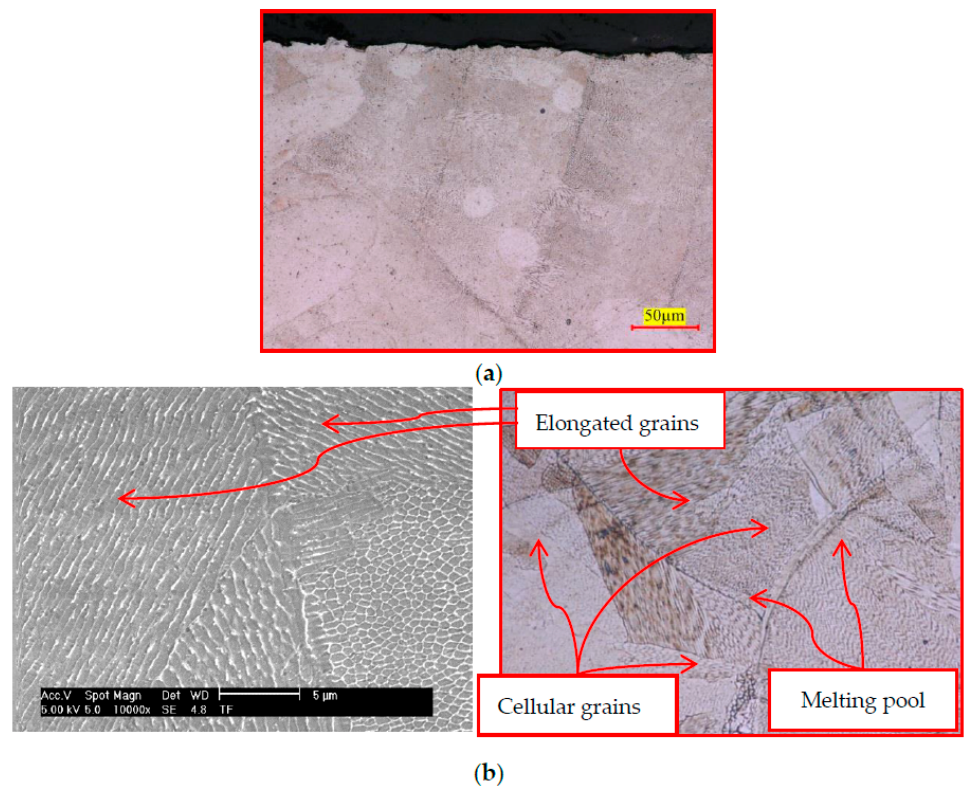
Figure 3. ( a )Microstructure of surface and subsurface of as-built SLMed part, ( b ) The detail of melting pool and grain structure of as-built SLMed part.